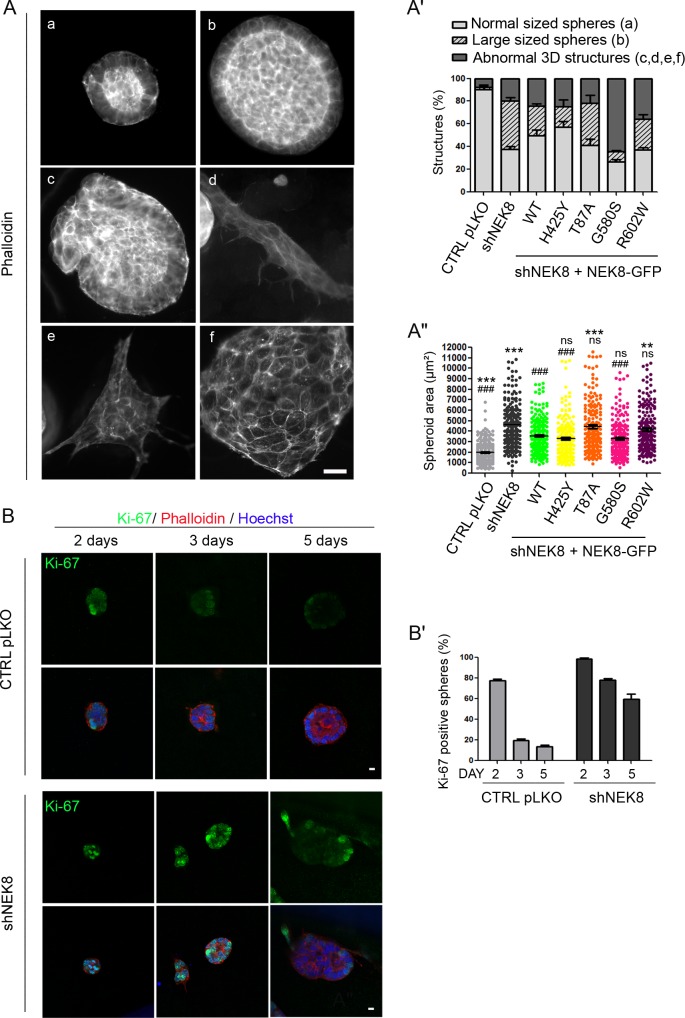
Abnormal 3D structures in shNEK8 and shNEK8 re-expressing NEK8 mutant protein cells.(A) 3D structures formed by shNEK8 and shNEK8 re-expressing NEK8 mutants. Cells were grown for 5 days in matrigel prior to phalloidin staining and six categories of structures were observed: (a) normal-sized spheres, (b) large-sized spheres, (c) malformed structures with lumen, (d) elongated structures, (e) branching structures and (f) aggregates without lumen. (A’-A”) Graphs (mean ± SEM of three independent experiments) showing the distribution of normal versus abnormal structures (A’) and quantification of the sphere areas (A”) for each cell line. Scale bar, 10 μm. Statistical analyses by Bonferroni post-hoc test following ANOVA, ns = non significant, **p < 0.01, ***p < 0.001 when samples are compared to shNEK8 + NEK8-GFP WT and ###p < 0.001 to shNEK8. (B). Three-dimensional (3D) spheroids derived from control pLKO and shNEK8 cells were fixed after 2, 3 and 5 days of culture, and were stained for Ki-67 (green), phalloidin (red, F-actin), Hoechst (blue, nuclei). Equatorial sections of representative spheres are shown. Scale bars, 10 μm. (B”) Quantification of Ki-67-positive spheres at 2, 3, and 5 days of culture.